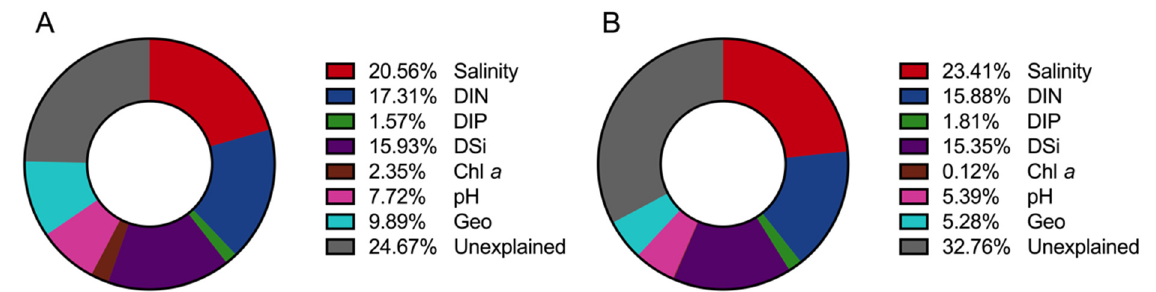
Figure 3. Pie charts for the independent explanation of environmental factors by hierarchical parti- tioning. The percentage value was the proportion of the variation explained by each environmental factor to the total variation of bacterial ( A ) and protistan ( B ) communities.